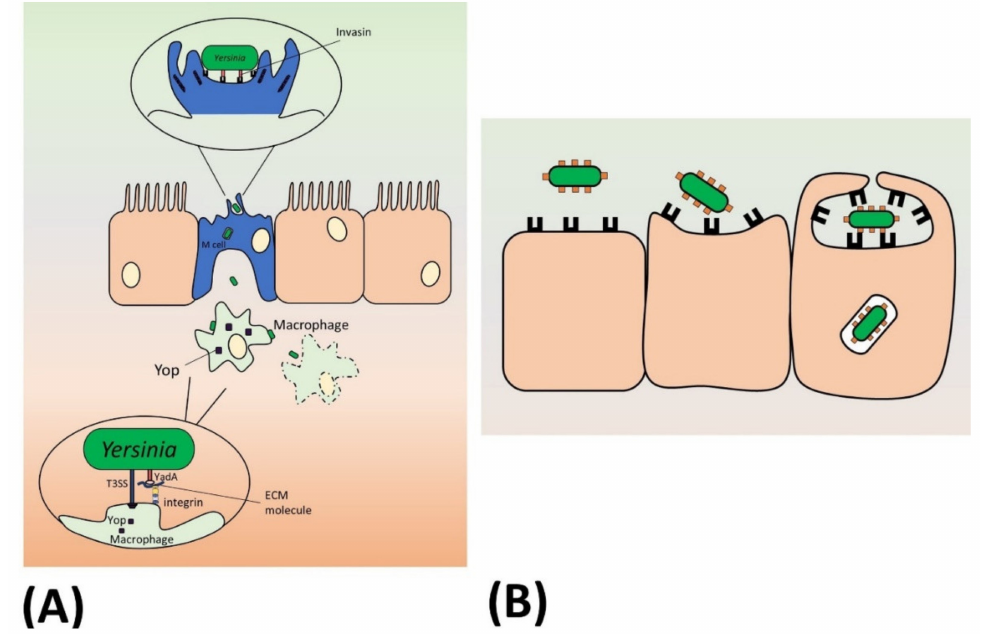
Figure 5. Schematic of enteropathogenic Yersinia pathogenesis. ( A ) In the distal ileum, Yersiniae bind to β 1 integrin-expressing M cells via the inverse autotransproter invasin. This leads to internalisation of the bacteria and transcytosis through the M cell into the underlying Peyer’s patch, where the bacteria come into contact with immune cells such as neutrophils and macrophages. At this stage, the extracellular bacteria bind to immune cells via the TAA YadA. YadA binds to extracellular matrix (ECM) molecules such as collagen and fibronectin, which in turn are bound to host cell surface receptors such as integrins. The binding of YadA to the target cell through a bridging ECM molecule allows injection of Yops by the Ysc T3SS, which prevents phagocytosis and leads to apoptosis of the immune cells. In this way, the plasmid-encoded T3SS and T5SS (YadA) act together to evade phagocytosis and establish an extracellular infection. ( B ) Mechanism of invasin-mediated internalisation into host cells by the zipper mechanism. Invasin (orange) binds to β 1 integrins on the host cell surface (black structures). This induces outside-in integrin signalling and changes to the actin cytoskeleton, which leads to engulfment of the bacteria by a zipper-like mechanism. YadA can also in some cases promote bacterial uptake by a similar mechanism via a bridging ECM